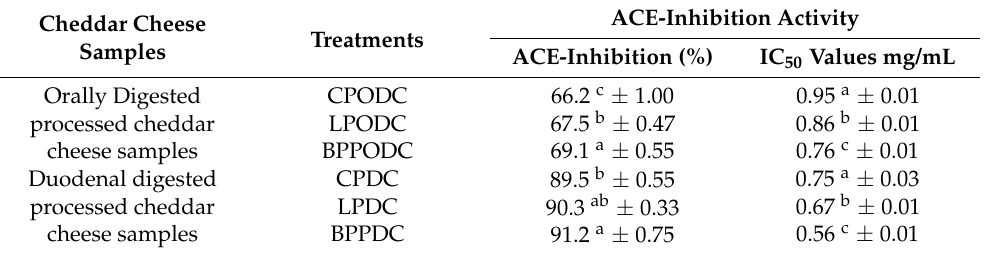
Table 1. ACE inhibitory activity is expressed as IC 50 value (as the amount of protein content needed to inhibit 50% of the ACE inhibitors).